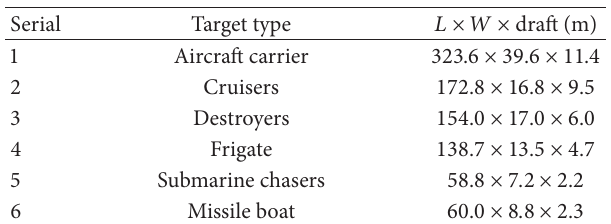
Table 1: Ship targets